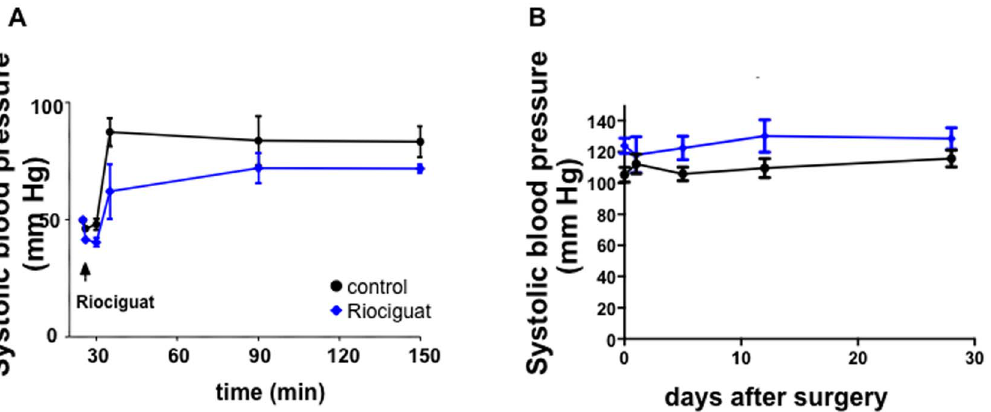
Figure 6. Effects of riociguat on hemodynamics. ( A ) Systolic blood pressure data were obtained by using a LV-catheter during infarct size measurement in the acute model with 30 min ischaemia followed by 2 h reperfusion. There was a slight blood pressure drop after riociguat injection compared to the vehicle-treated mice in the control group, although changes are not significant. n=3. ( B ) Long term systolic blood pressure data were obtained by using a tail cuff system. One day after injection of riociguat systolic blood pressure still showed a mild trend towards lower values, which fully disappeared later. n=7.